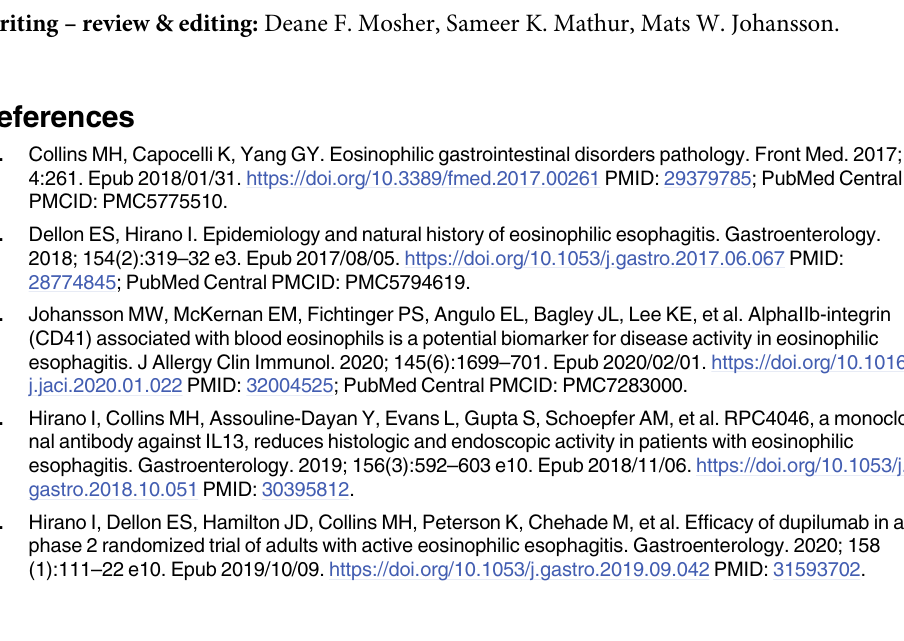
S3 Table. CD41 expression level on CD41-positive and all leukocytes, and correlations with percentage CD41 positivity and PEC, at V2. S4 Table. Correlations between leukocyte CD41 positivity or principal component analysis (PCA) factors and PEC at V2, adjusted for RCAT or allergy and asthma. S5 Table. Percentage CD41-positive leukocytes (median and quartiles) at V1 and V2 in subjects with PEC < or > 6/HPF at